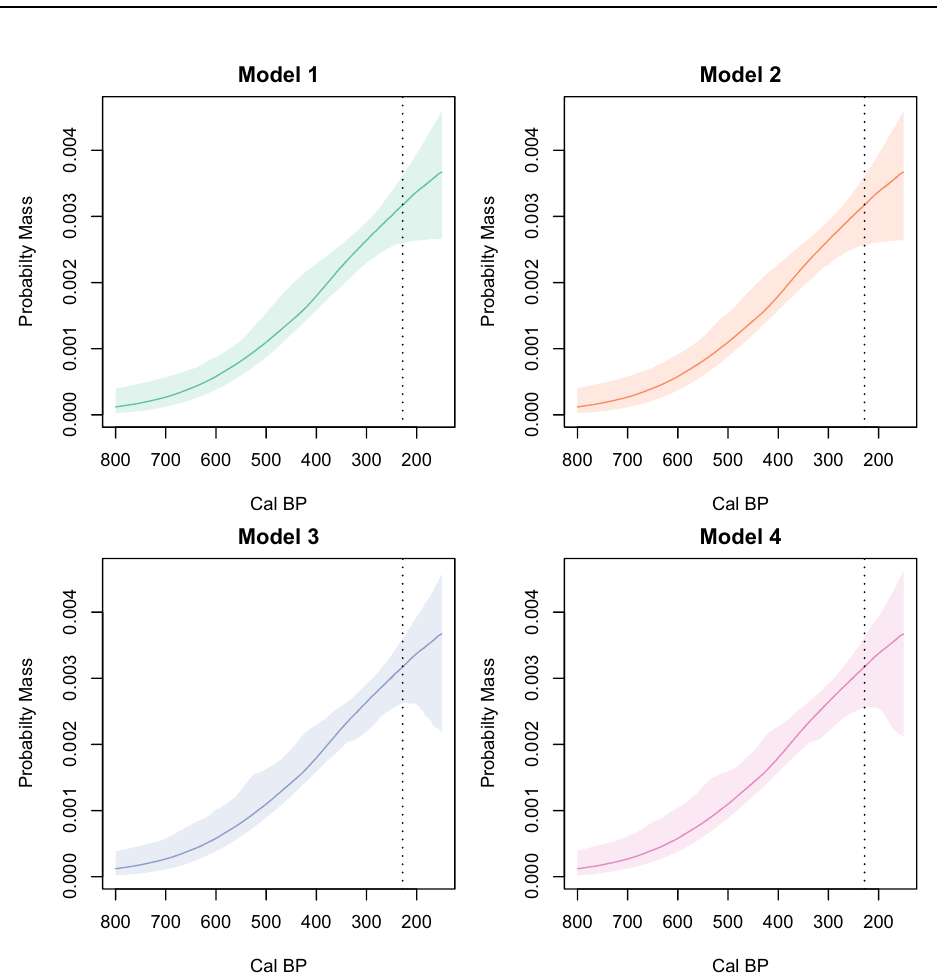
Fig. 3 Median and 95% HPD values for four demographic models. Model 1 is a simple logistic growth curve, Model 2 is a logistic growth curve with a forest cover effect, Model 3 is a logistic growth curve with a climate effect from the SOI, and Model 4 is a logistic growth curve with palm forest cover and SOI. The colored areas indicate the 95% HPD envelope. The vertical dashed lines mark the timing of European arrival in AD 1722. Note that the HPD for all models includes the possibility of a demographic plateau after AD 1722, Models 3 and 4 include the possibility of a decline after European contact.